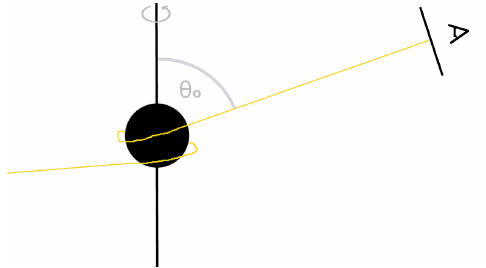
Figure 1 . Illustration of the setup with one ray of light (yellow) that is emitted by a source far away from the black hole: light circles the rotating black hole that is pierced by a cosmic string which coincides with the black hole spin axis. It then reaches the screen of a distant observer. The angle θ o is the inclination of the observer from the black hole spin